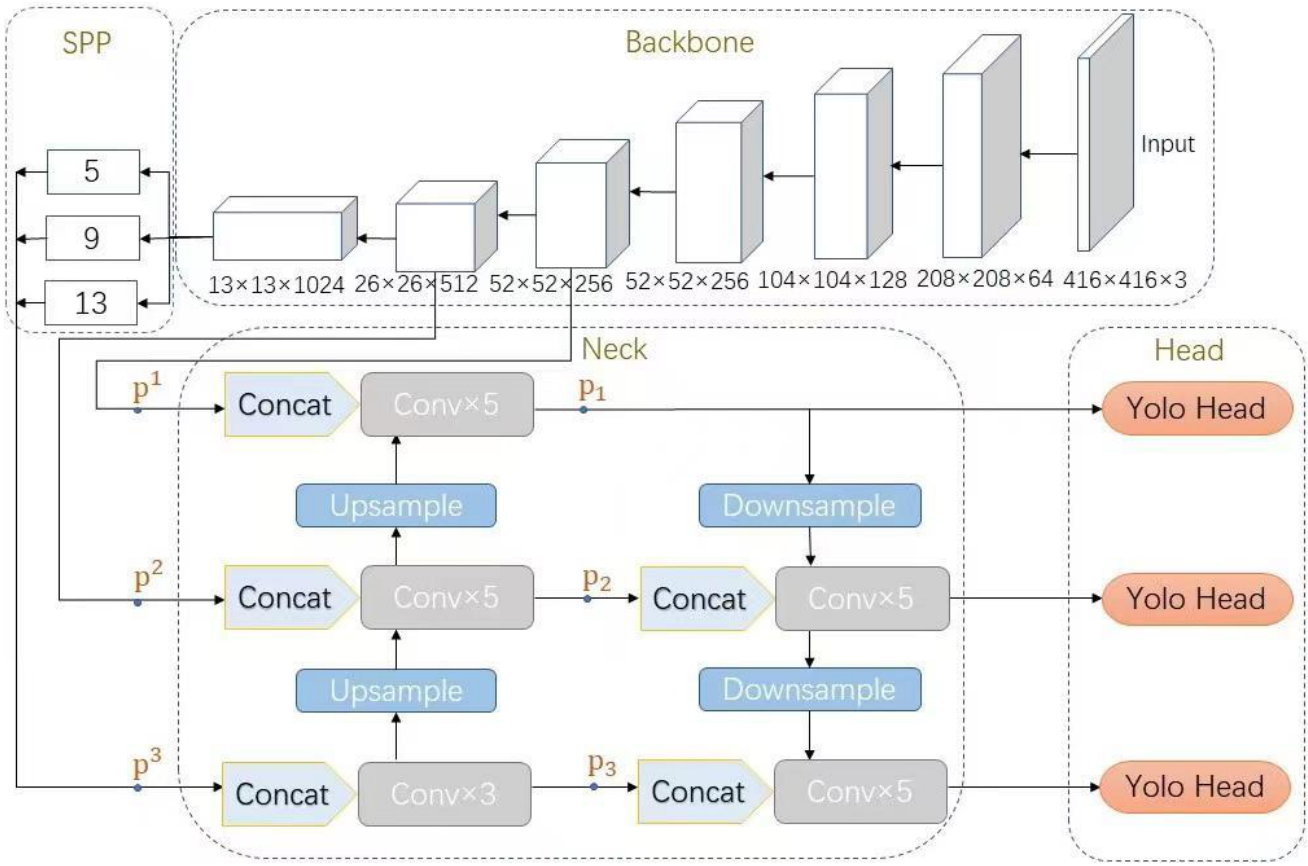
Figure 4. The structure diagram of YoloV4 network. Note: SPP stands for spatial pyramid pooling, Concat stands for tensor stitching, Conv stands for convolution, Yolo Head stands for YOLOv4 network header function.